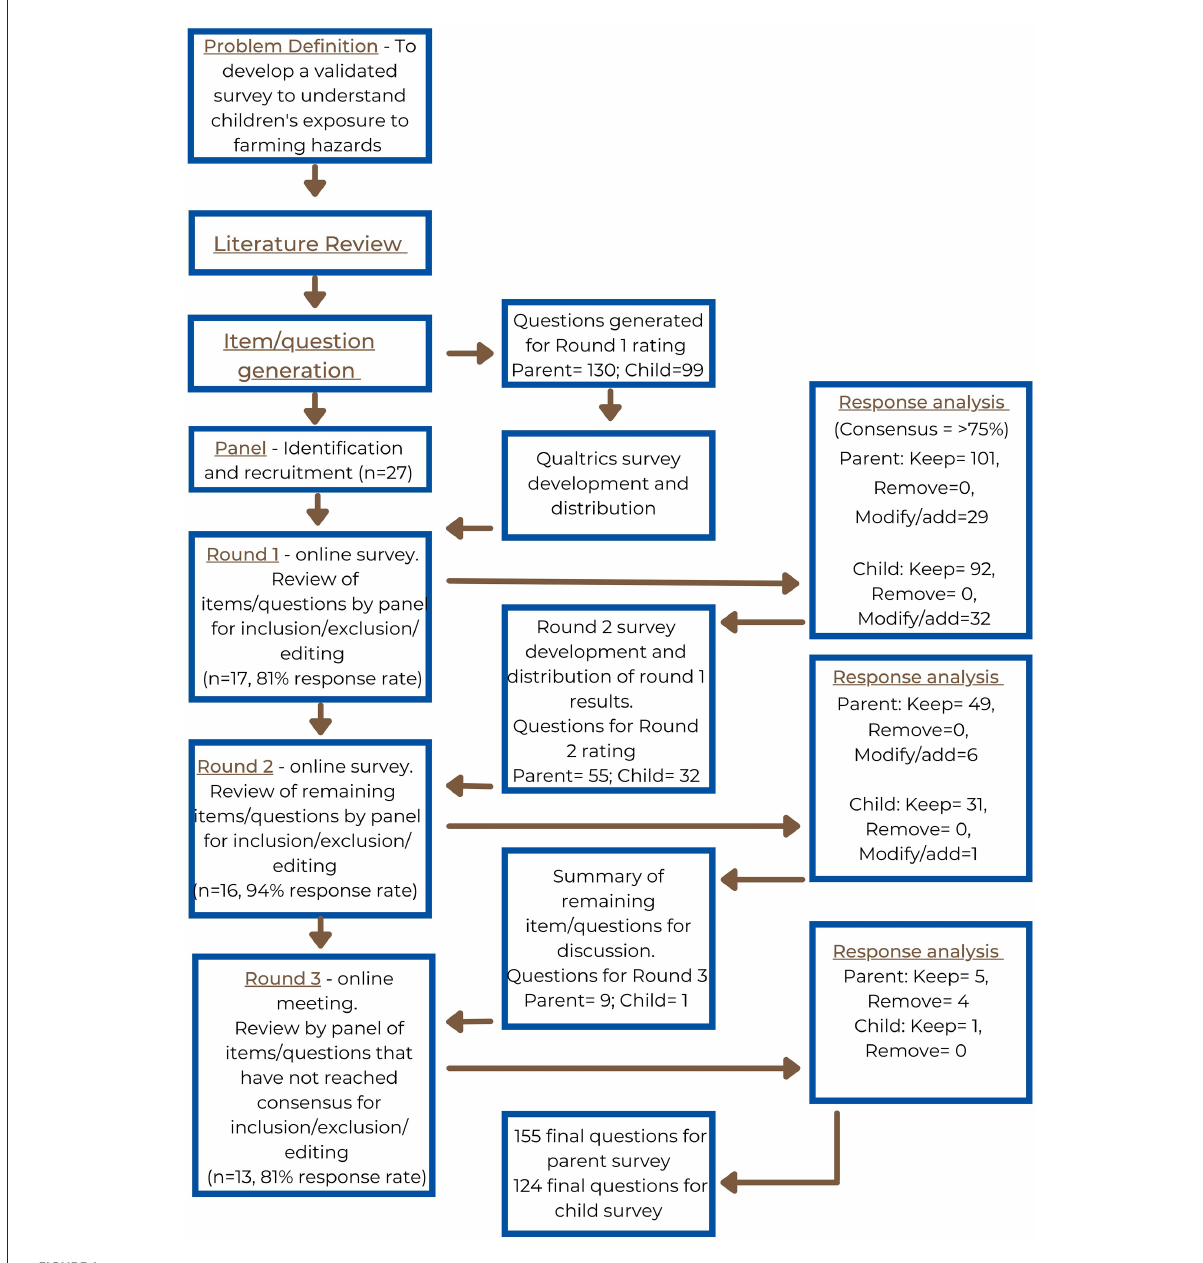
FIGURE1 The modified Delphi method utilized in this study